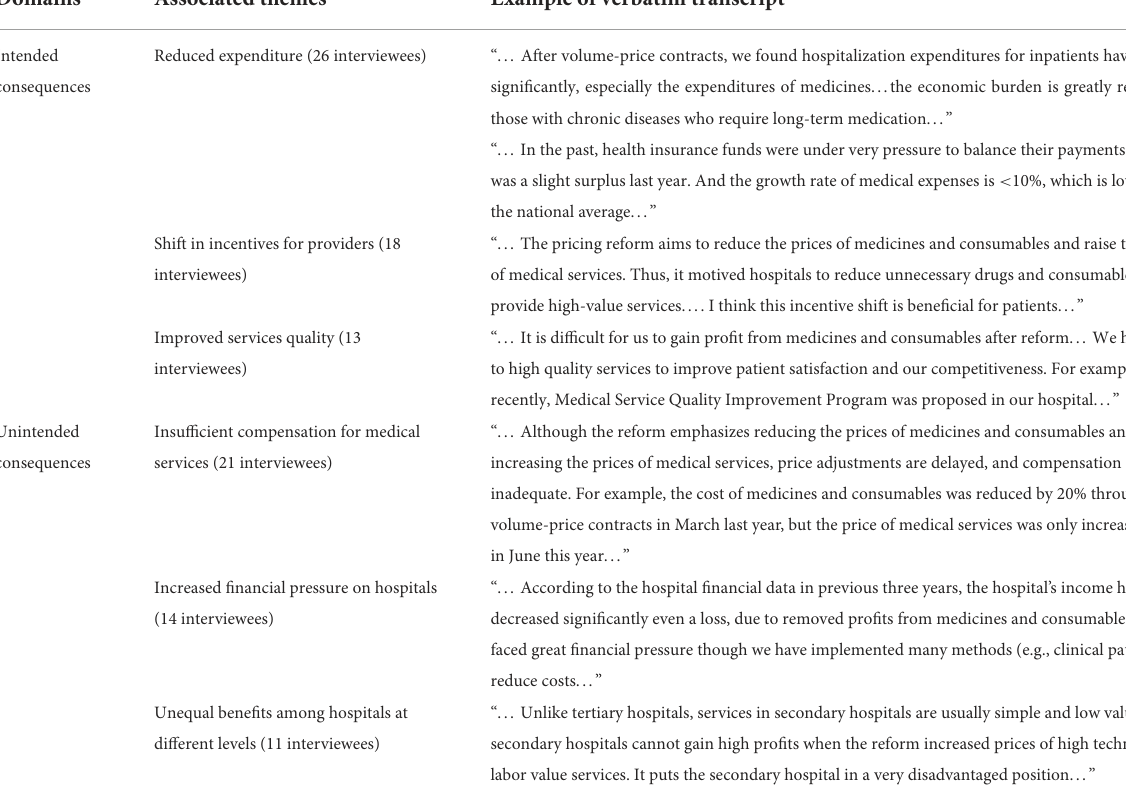
TABLE 4 Content analysis results for effects of public hospital